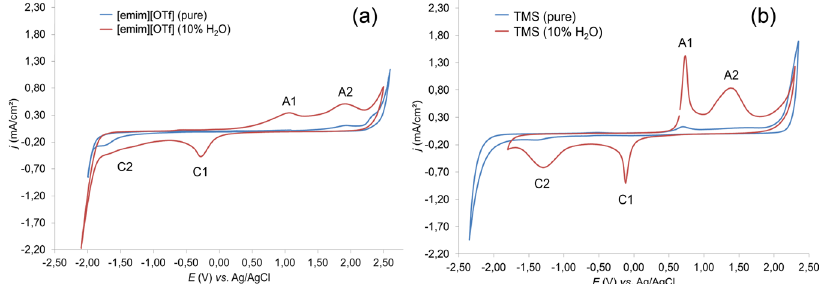
Figure 2. Cyclic voltammograms of pure (blue) and ‘water-contaminated’ (red) electrolytes ( a ) 1-ethyl-3- methylimidazolium trifluoromethanesulfonate ([emim][OTf]) and ( b ) triethylammonium methanesulfonate (TMS) (scan rates, 0.05 V/s).